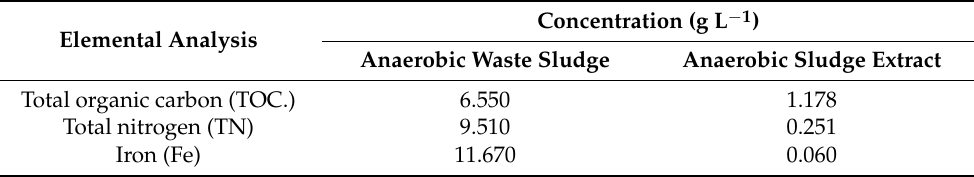
Table 3. The composition of anaerobically digested waste sludge supplied by Levapan S.A before and after